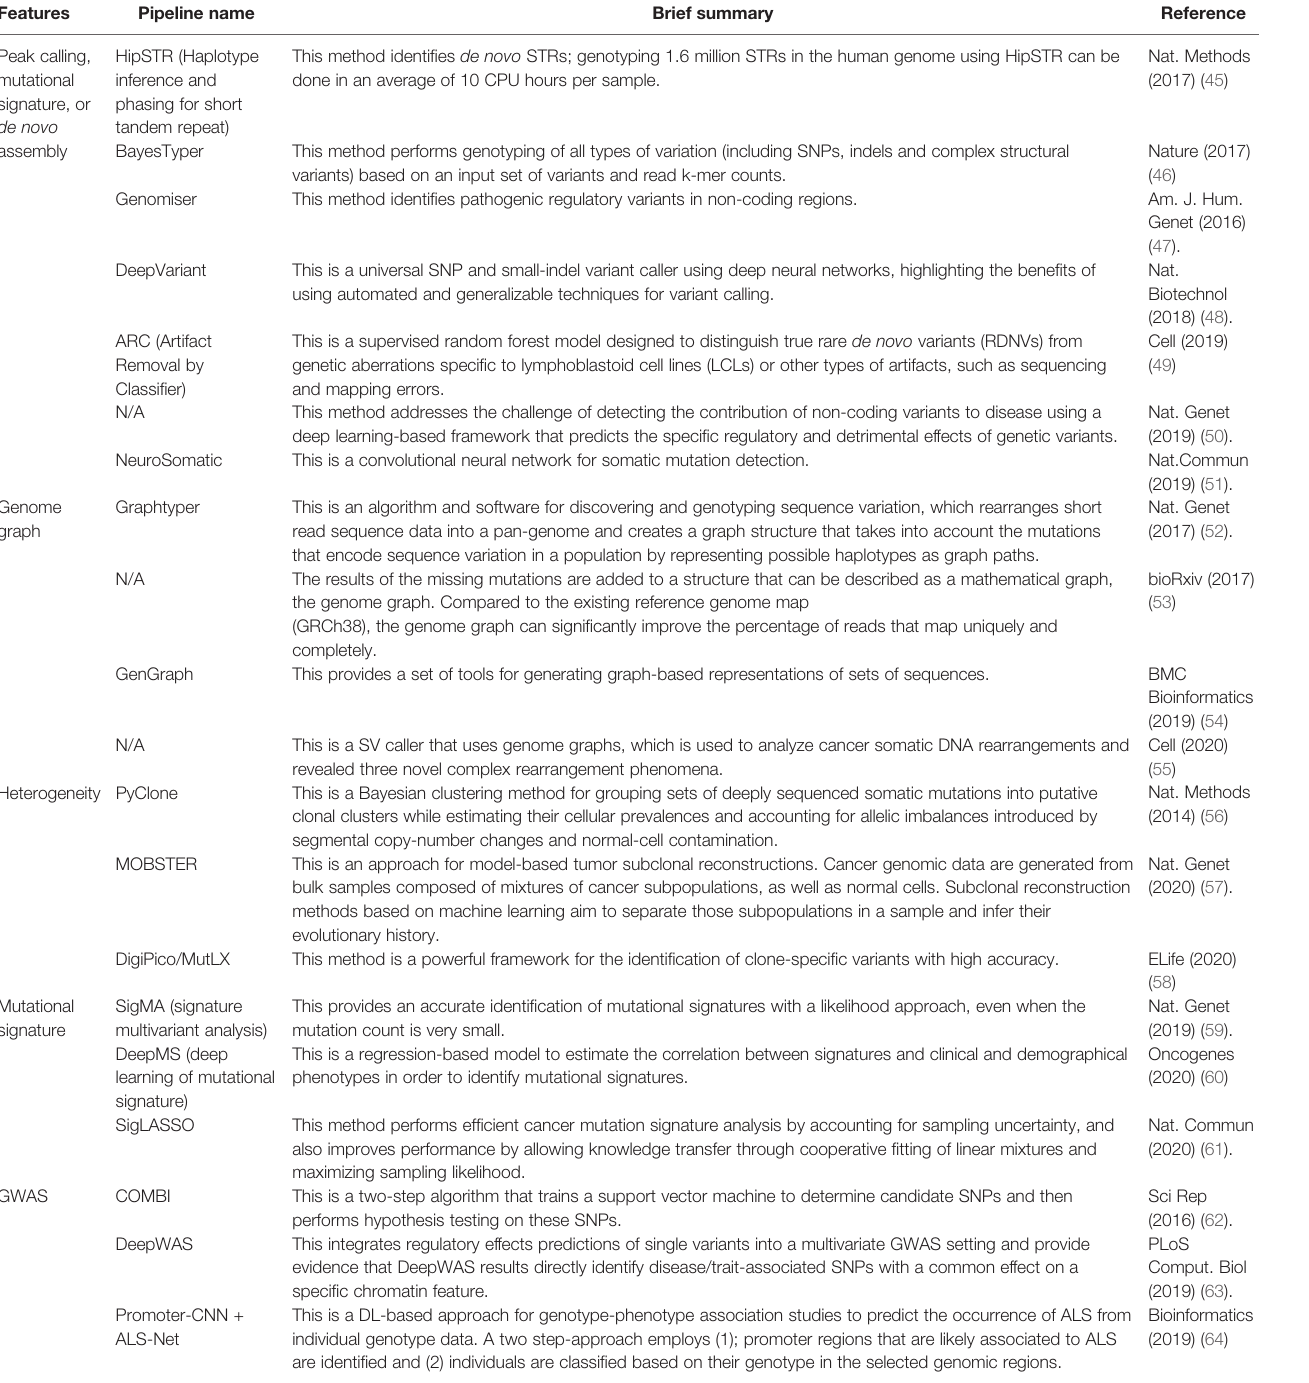
TABLE 1 | Overview of whole genome analysis using machine